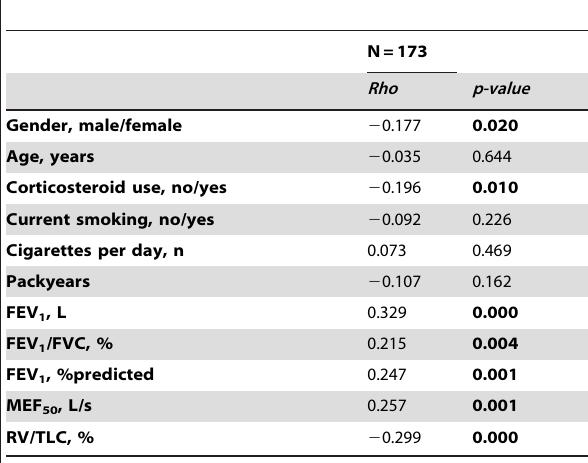
Table 2. Univariate correlations of skin blanching response with clinical